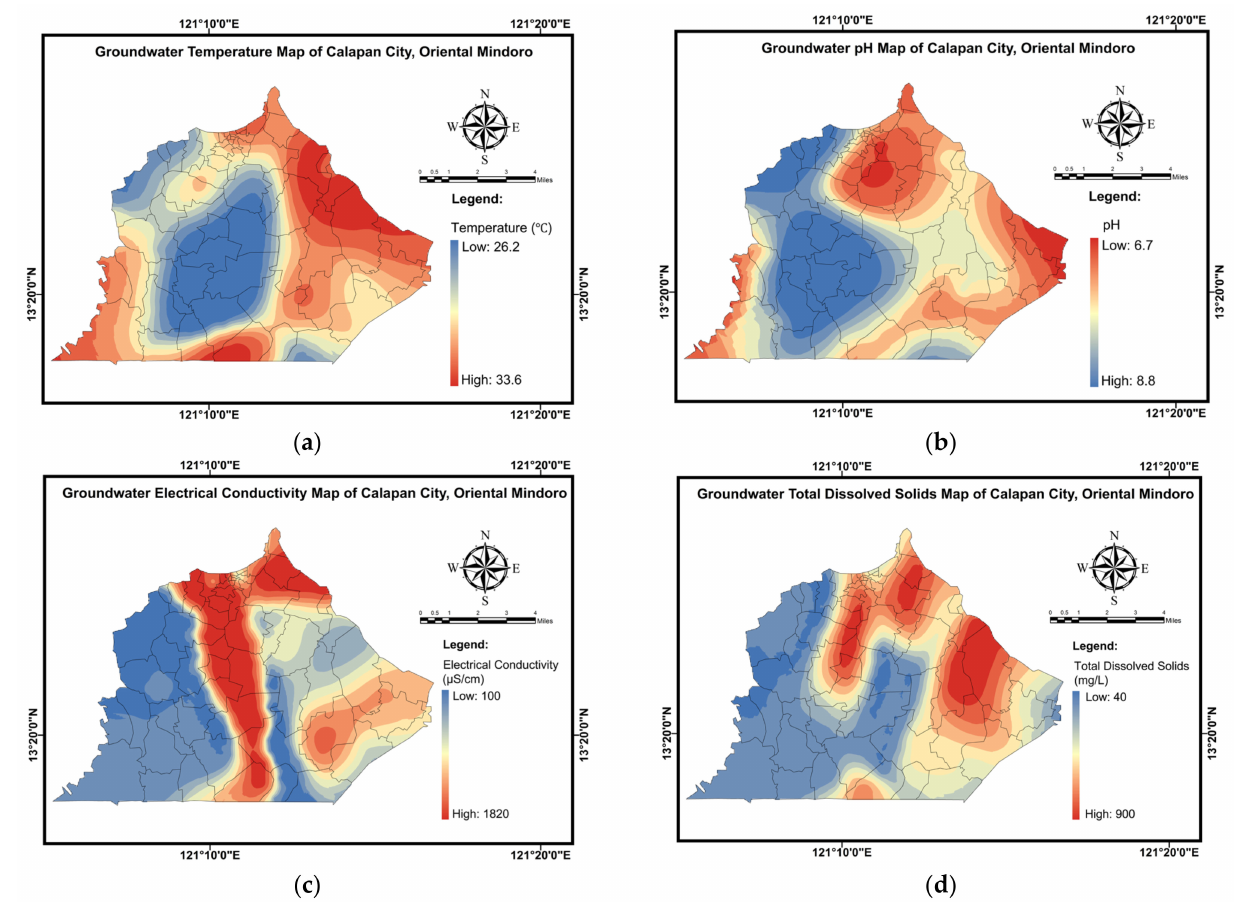
Figure 10. Physicochemical parameters map of Calapan City ( a ) Temperature, ( b ) pH, ( c ) EC, and ( d ) TDS.